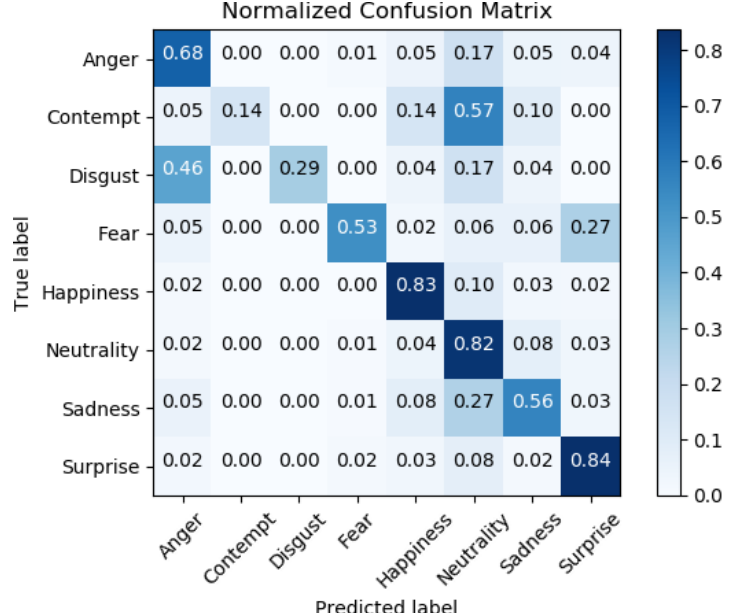
Figure 7. Normalized confusion matrix of the network in [22], trained with the FER2013 database with the FER+ annotations using the data augmentation and the z-score normalization. Figure from